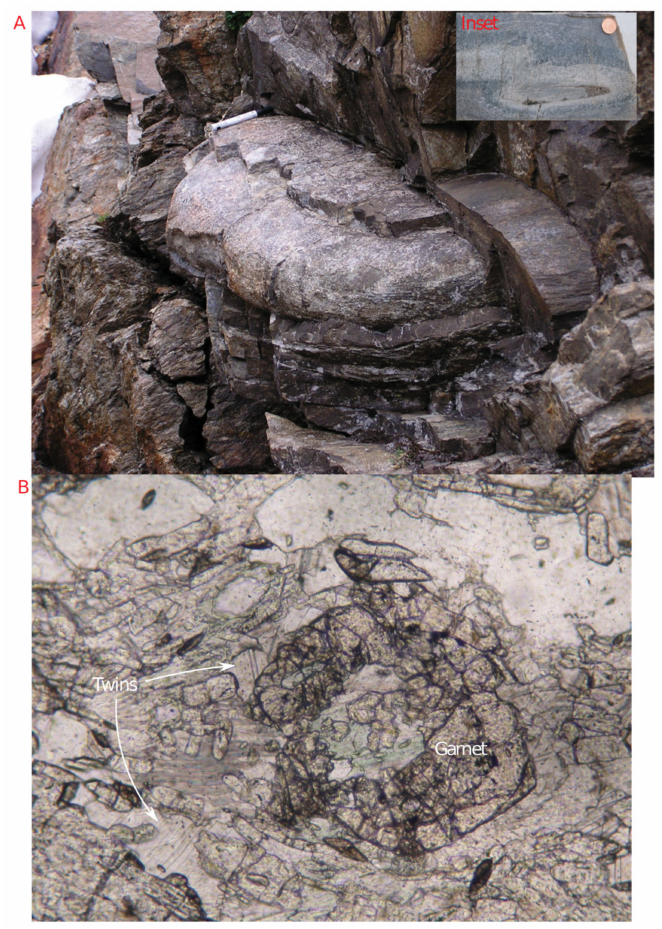
Figure 6. ( A ) Calcsilicate sheath folds in the Tauern window near Tyrol, Austria, including a section cut perpendicular to the fold axis (inset; penny for scale) and ( B ) photomicrograph of garnet (PL) surrounded by twinned calcite. Strain data in Tables 1 and